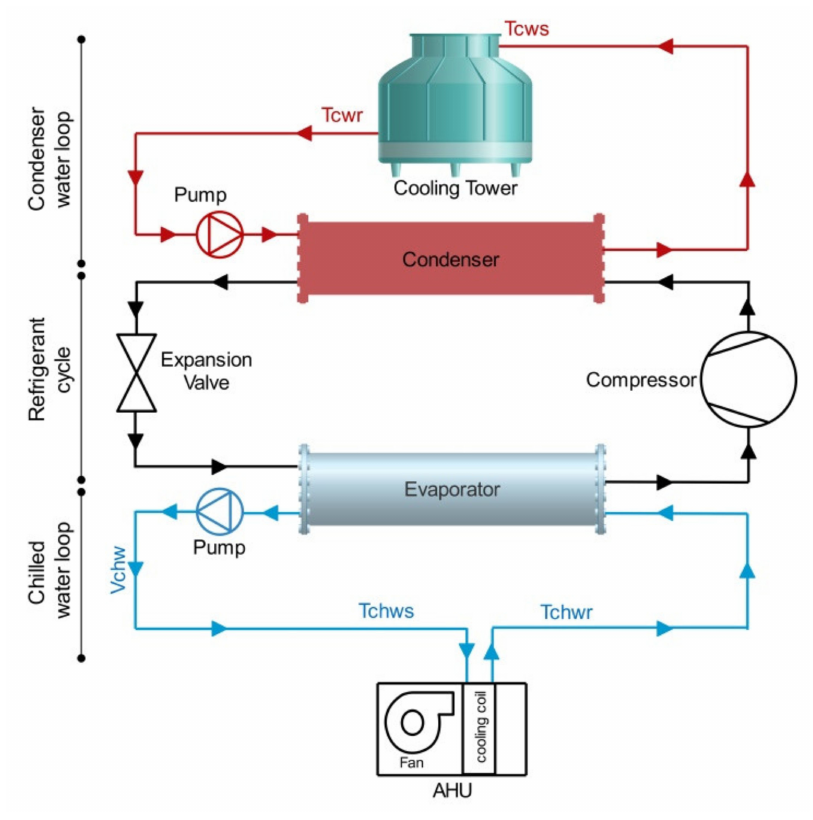
Figure 2. Water-cooled chiller system diagram and the measurement points